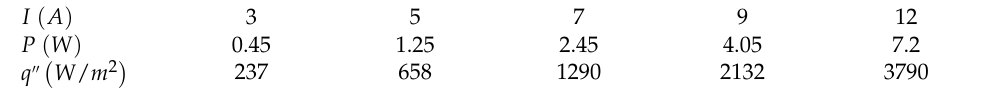
Table 2. Power and heat flux values imposed by varying the current